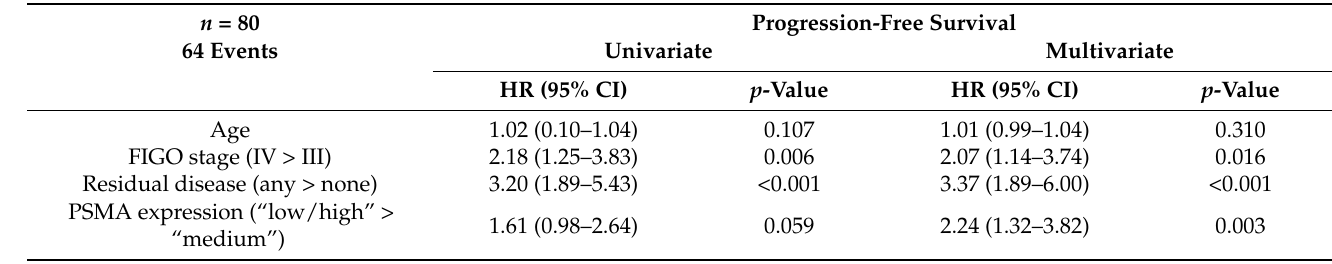
Table 2. Progression-free survival, univariate, and multivariate